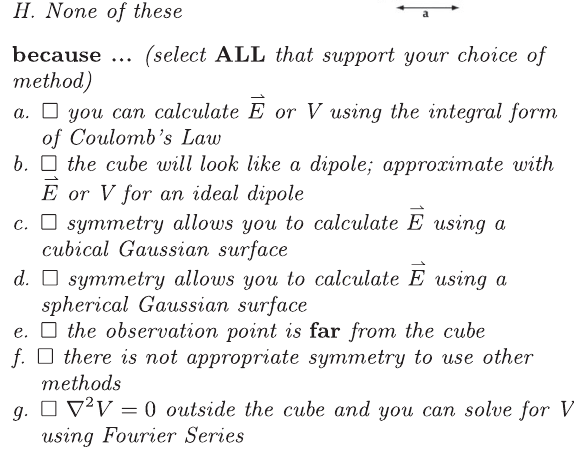
FIG. 2. A sample item from the CMR CUE. Question prompt has been paraphrased; see Supplemental Material [41] for full prompt and Ref. [40] for rubric and scoring